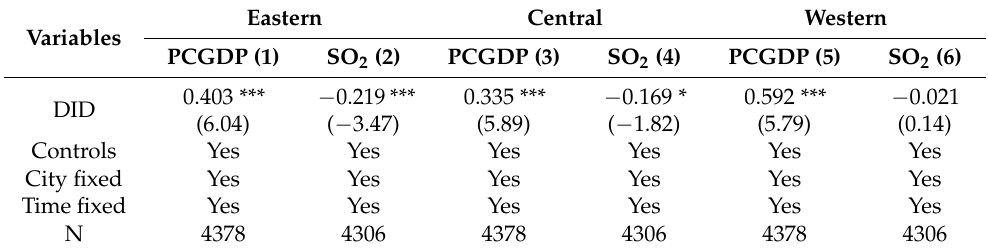
Table 7. The heterogeneity test at the regional level.